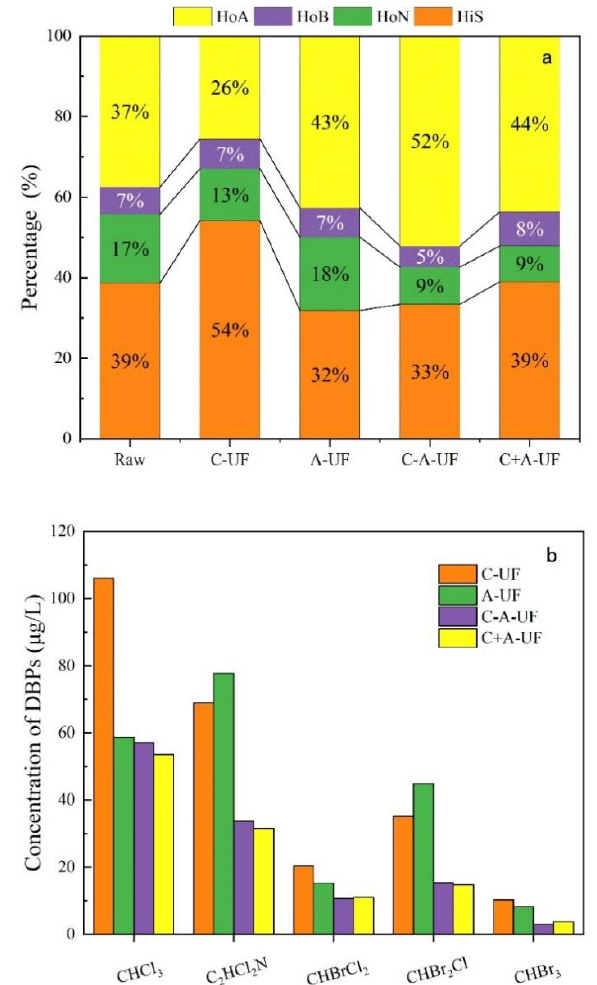
Figure 5. Classification of Natural organic matter (NOM) components in raw and treated waters ( a ), and the concentration of disinfection by-products (DBPs) ( b ) in treated